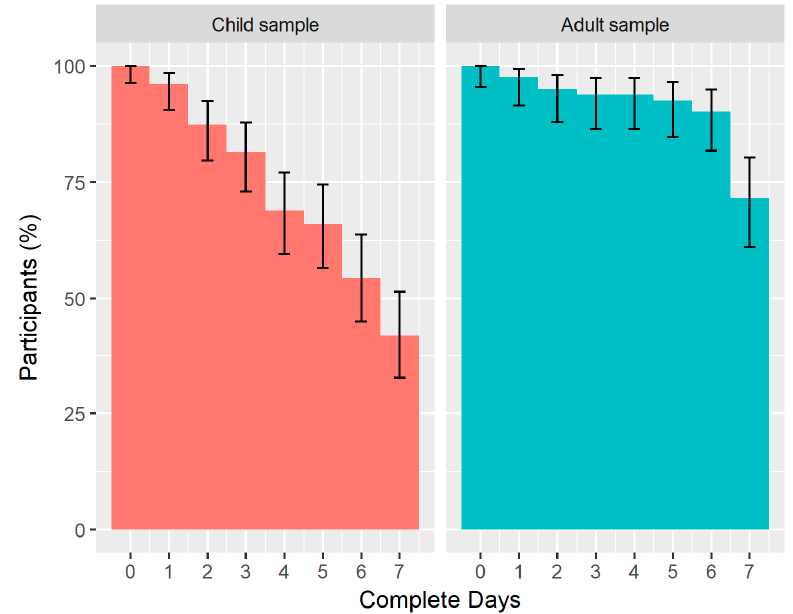
Figure 5. Number of complete 24 h days of data obtained from paired Axivity AX3 accelerometers in children and adults. Error bars represent 95% binomial proportion confidence intervals, calculated using the binconf function in the Hmisc R package.